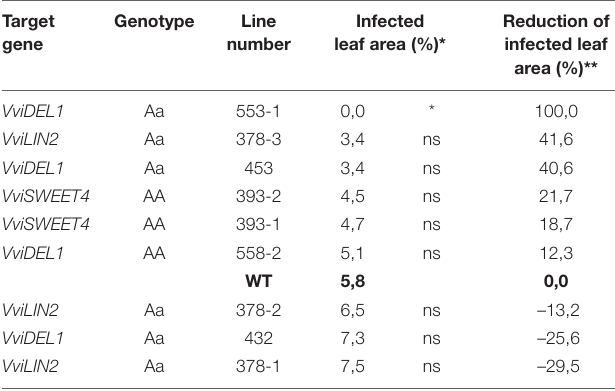
TABLE 3 | Powdery mildew infected leaf area rates of representative edited and non-edited grapevine plants under greenhouse conditions. Target